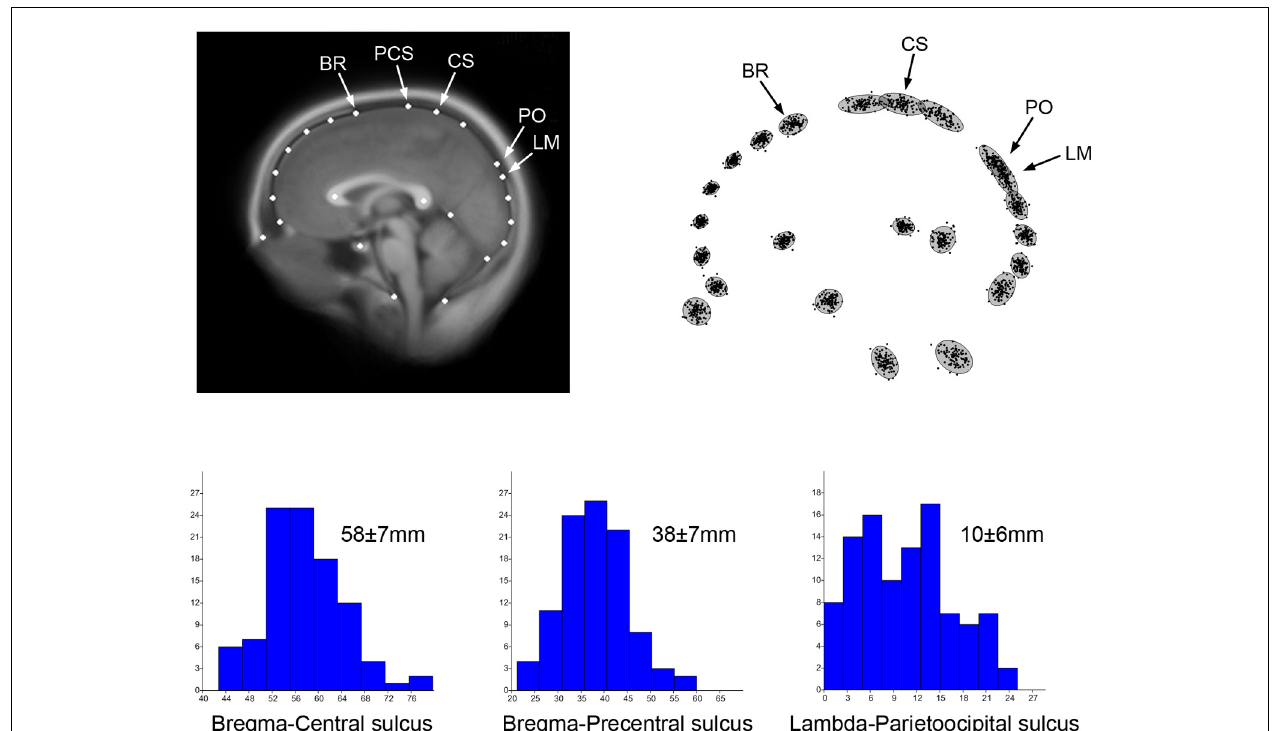
residuals after normalization of the form differences.The histograms show the distribution of the absolute distances between brain and cranial landmarks, with average and standard deviation.The distance bregma-central sulcus represents the distance between frontal bone and frontal lobe.The distance bregma-precental sulcus represents the part of prefrontal lobe covered by parietal bone.The distance lambda-parietooccipital sulcus represents the distance between occipital lobes and occipital bone.These spatial relationships between brain and braincase are of special interest for both paleoneurology and